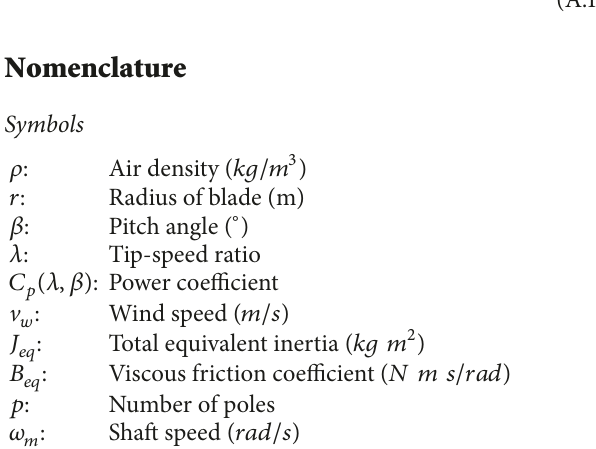
Figure 14: The DC-link voltage profile during a single-phase voltage drop. 𝑈 = 5, 𝑀−𝑞𝑓 𝑘 = 2. 𝑞𝑓